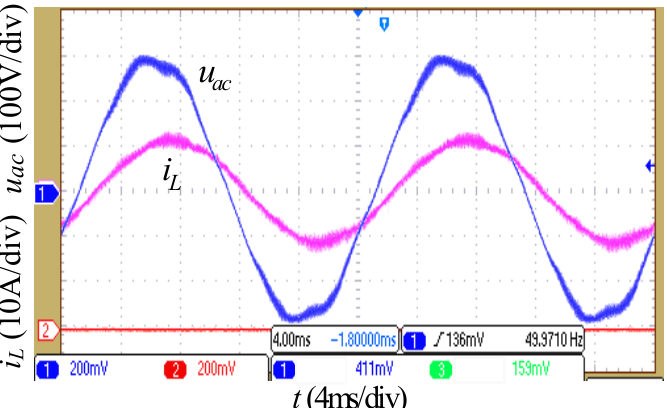
Figure 21. Voltage and inductor current under the HMM for 30 ◦ phase shift between voltage and current. HMM: Grid voltage and current, θ = − 30°.